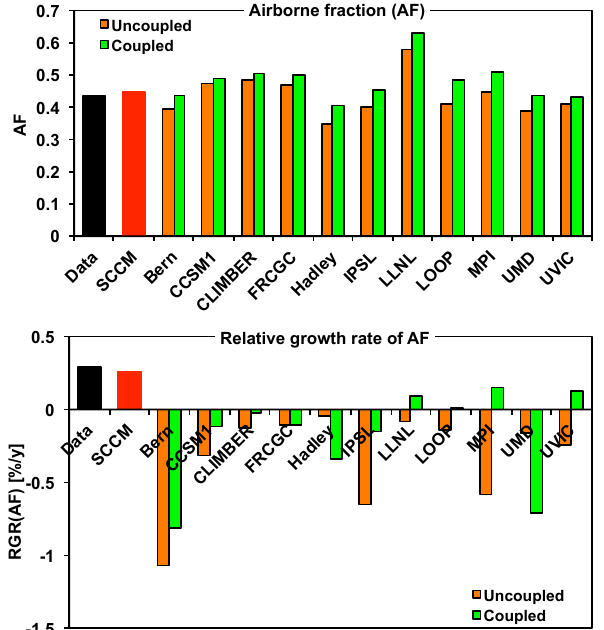
Figure 9 (source: C4MIP.EmissionsCO2.AFTrend+SinkRate.V04.xls) Figure 9. Upper panel: mean sink rate k S over 1959.0–2013.0 from data (black bars), SCCM (red bars) and 11 C4MIP models (Friedlingstein et al., 2006) in both uncoupled and coupled modes (orange and green bars, respectively). Lower panel: relative growth rate RGR( k S ), estimated using Eq. (A2). See Fig. 8 caption for note on consistency of SCCM trend estimates between Figs. 9 and